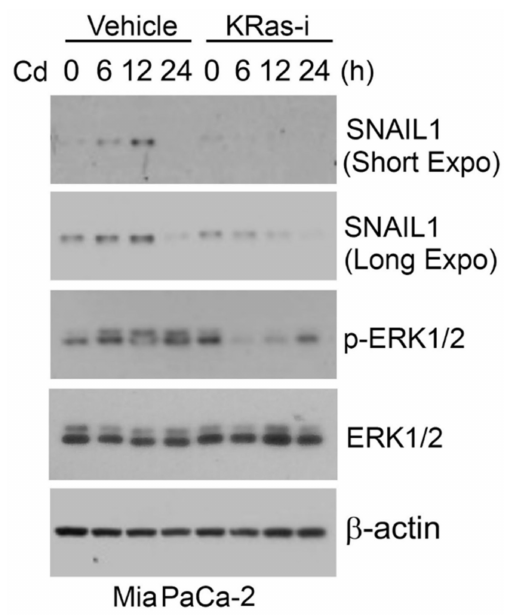
Figure 1. Cadmium induces expression of SNAIL1. MiaPaCa-2 cells were treated with cadmium chloride (10 µ M) in the presence or absence of a specific KRas G12C inhibitor (ARS-1620) for various times as indicated. Equal amounts of cell lysates were blotted for SNAIL1, phospho-ERK1/2, total ERK1/2, and β -actin. For original Western Blot, see Figure S1.